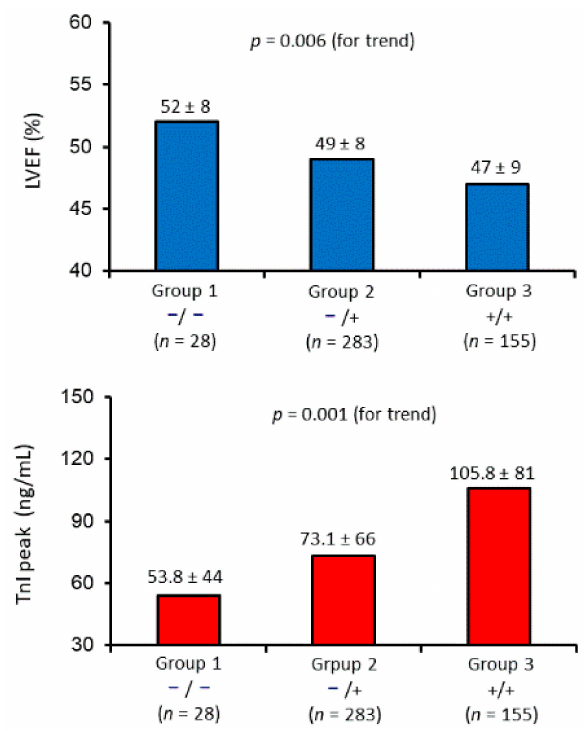
Figure 1. Left ventricular ejection fraction (LVEF; upper panel) and high-sensitivity troponin I (hs-TnI; lower panel) peak values stratified according to cytochrome c and/or mtDNA detection at hospital admission (group 1 ( − / − ; none mitochondrial biomarker detected) vs. group 2 ( − /+; only one of the two biomarkers detected) vs. group 3 (+/+; both biomarkers detected)). p value for trend was obtained by one-way analysis of covariance (ANCOVA).